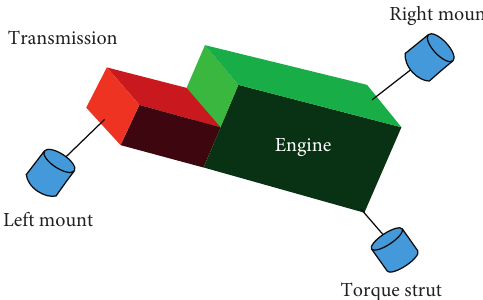
Figure 1: A six-degree-of-freedom model of a powertrain mount